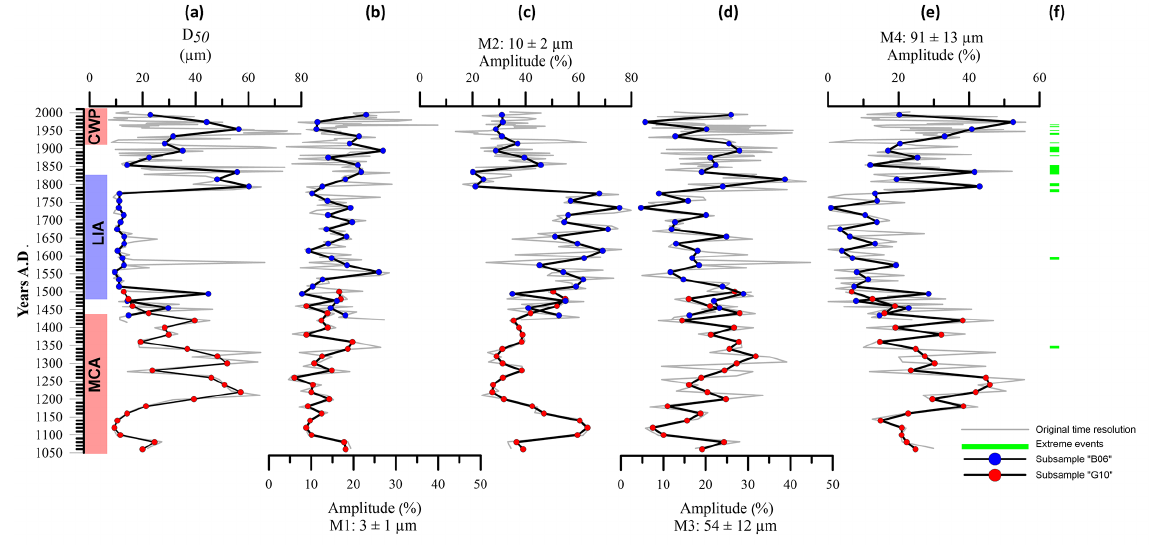
Figure 3. (a) Median grain size ( D 50) variation along the record and variation in relative abundance of the sedimentary components: (b) M1, (c) fluvial (M2), (d) aeolian (M3) and (e) aeolian (M4) of the grain size distribution in the record. (f) Samples where very large particles related to extreme events were found. Table 2. Minimum, maximum and average values of the grain size components in each climate unit obtained along the record in the Pisco continental shelf. First period MCA Second period